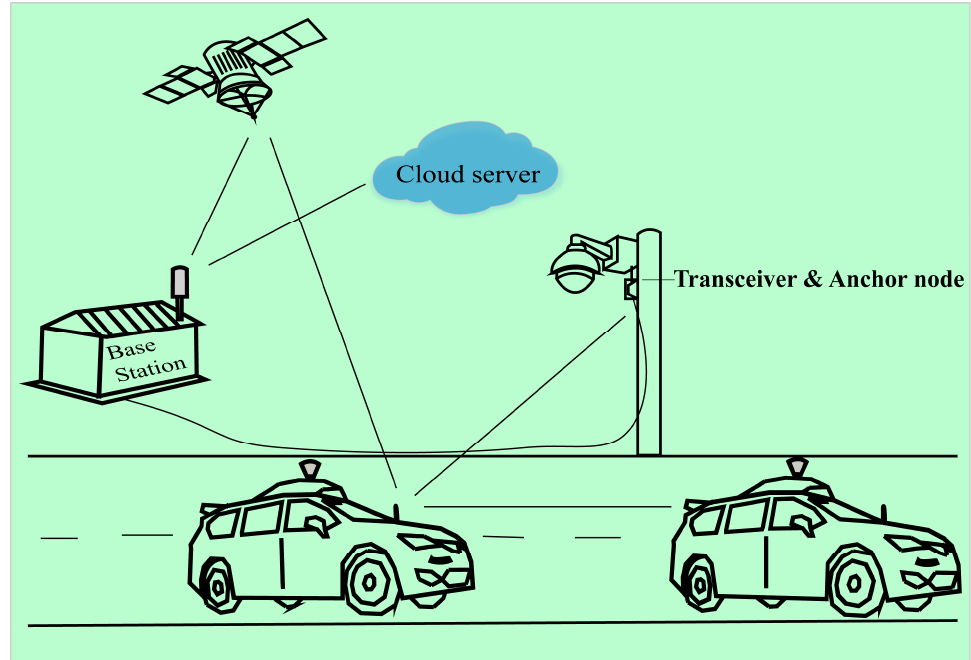
Figure 9. Proposed AI multi-networking technology for AV with modified traffic surveillance camera system.